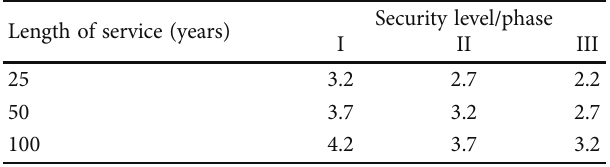
Table 13: Target reliability index of slope.